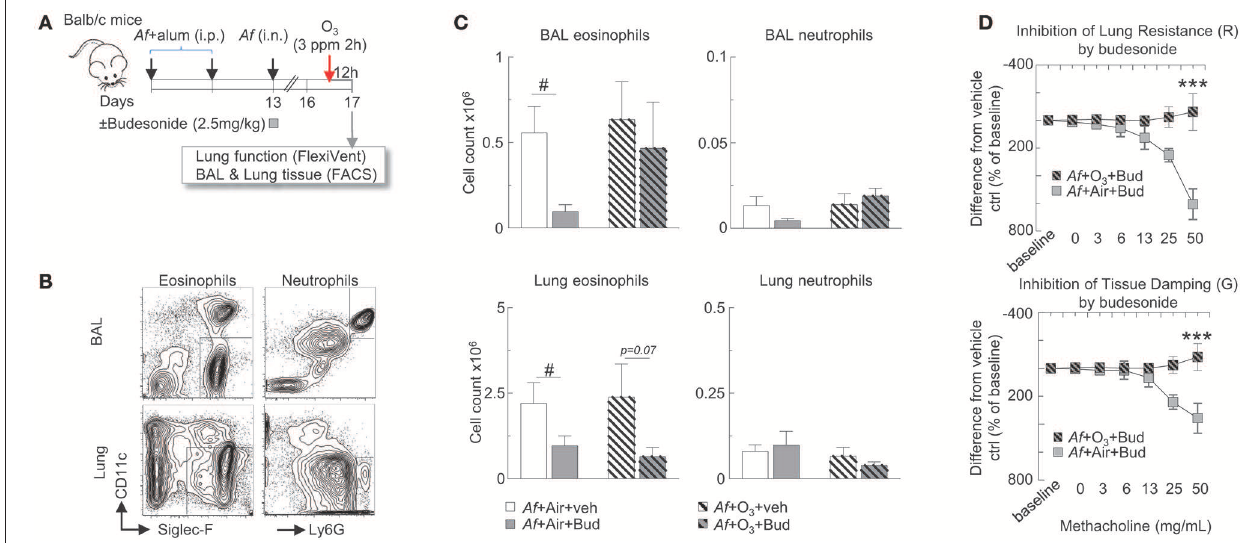
FIGURE 3 | The inhibitory effects of budesonide on Af -induced airway inflammation were attenuated and on airway hyperreactivity were completely abolished by O 3 exposure in sensitized and challenged mice. (A) Balb/c mice were sensitized to 20 µ g Aspergillus fumigatus ( Af ), with alum ( i.p. ) on days 0 and 7. On day 13, mice were challenged with 25 µ g Af ( i.n. ) and administered 2.5 mg/kg budesonide or vehicle (DMSO). 82h post- Af challenge, mice were exposed to air or 3 ppm O 3 for 2h, then 12h later (96h post- Af challenge), lung function was measured (Flexivent ® ), and BAL and lungs were harvested. (B) Representative gating of BAL and lung neutrophils (live Ly6G + CD11b + cells) and eosinophils (live CD11c − Siglec-F + cells). (C) The absolute numbers of eosinophils and neutrophils were calculated by multiplying the percentage of cells determined by flow cytometric gating with the total numbers of cells/lung or BAL (Countess ® ). Mean ± SEM of n = 6; # p < 0.05 Student’s t -test (vehicle vs. budesonide). (D) Lung resistance and tissue damping results were calculated as % change from baseline. The difference between the vehicle and budesonide treatment is depicted (by subtracting the individual % change from baseline values from the vehicle treatment average at each methacholine concentration). Mean ± SEM of n = 6–14; *** p < 0.001 ( Af + Air + Bud vs. Af + O 3 + Bud) Two-way ANOVA with Tukey’s multiple comparison’s test.